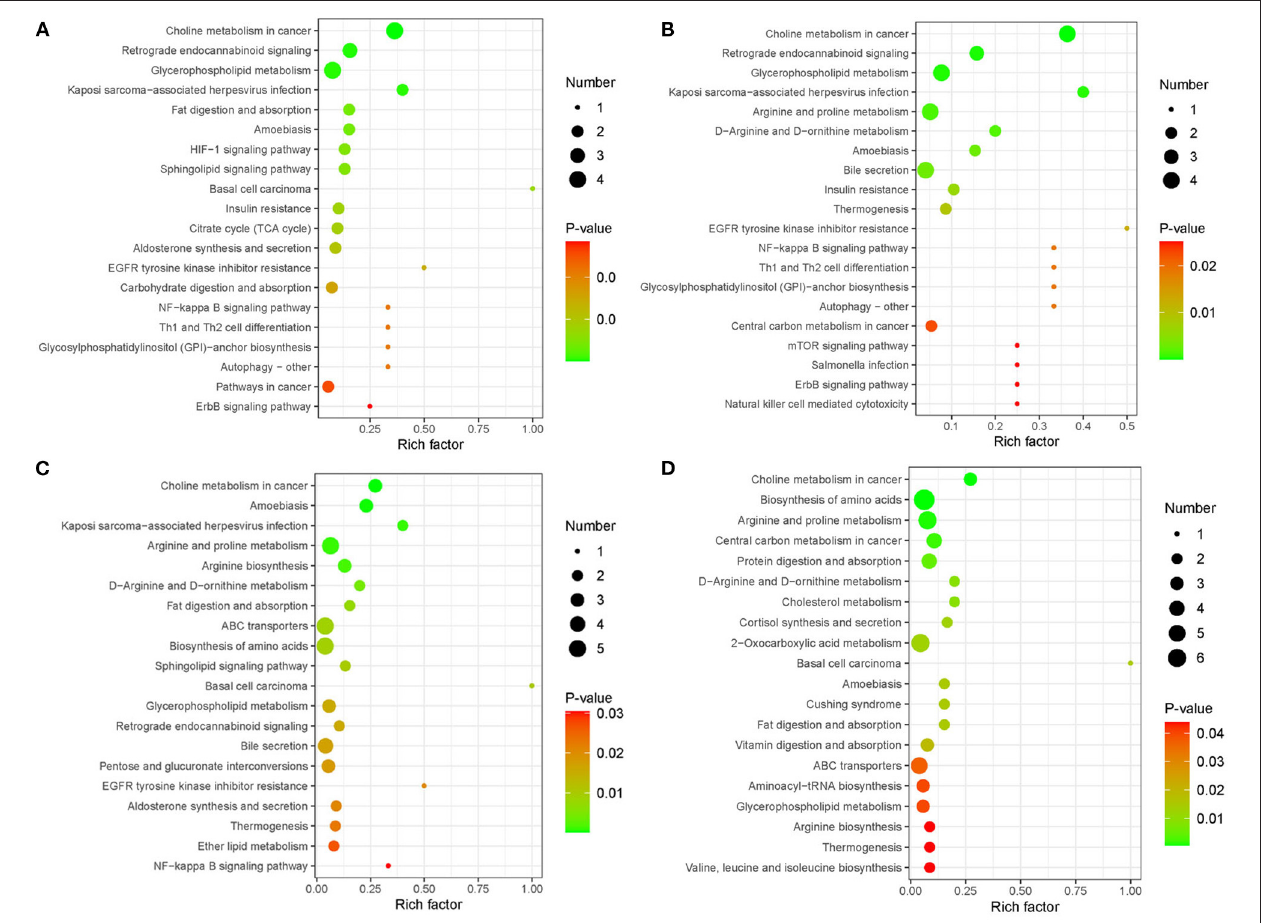
FIGURE 8 | Kyoto Encyclopedia of Genes and Genomes (KEGG) enrichment analysis of metabolic pathway in different combinations. (A) PBA0 vs. control. (B) PBA.1 vs. control. (C) PBA1 vs. control. (D) PBA5 vs.